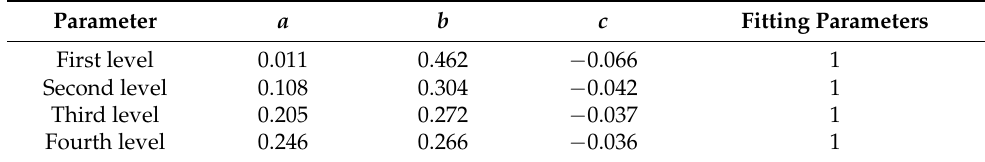
Table 4. Polynomial regression results for E ( x ). Figure 7. Variation curves of elastic modulus with disturbance load.